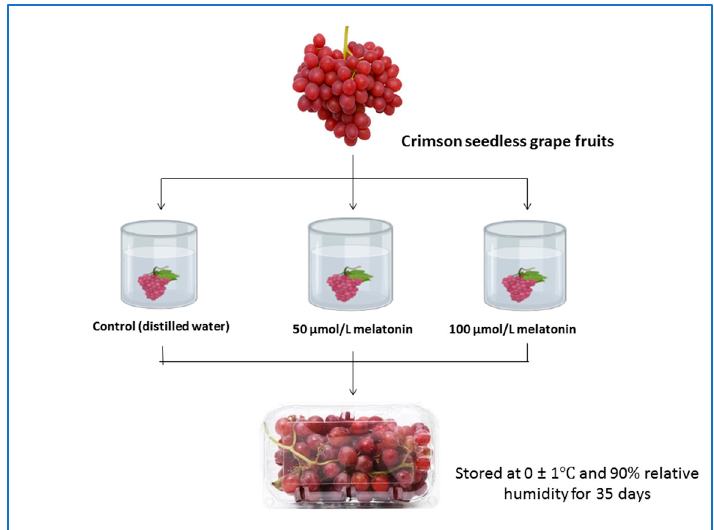
Figure 1. Treatments schema and the concentrations of melatonin .